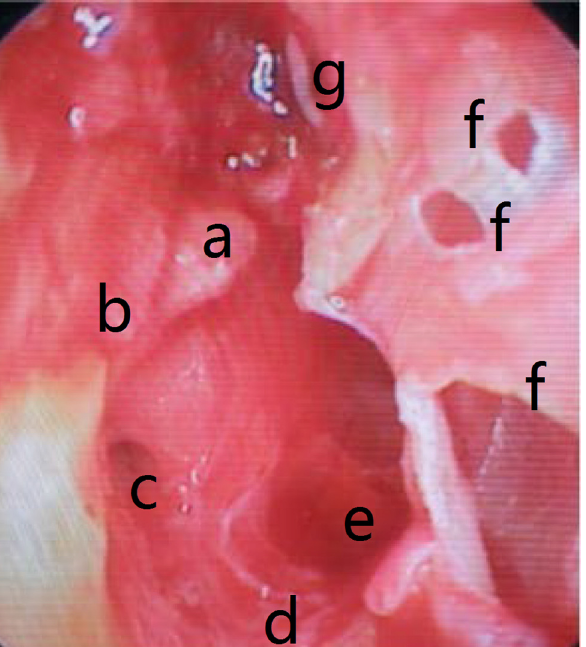
Fig 6. Postoperative middle ear endoscopic view (evidence of a minimal remaining cholesteatoma in the tympanic sinus). (a) Stapes capitalum; (b) The remaining cholesteatoma in the tympanic sinus; (c) Round window; niche; (d) Hypotympanic air cells; (e) Eustachian tube opening; (f) Tympanic membrane perforations; (g) Malleus.